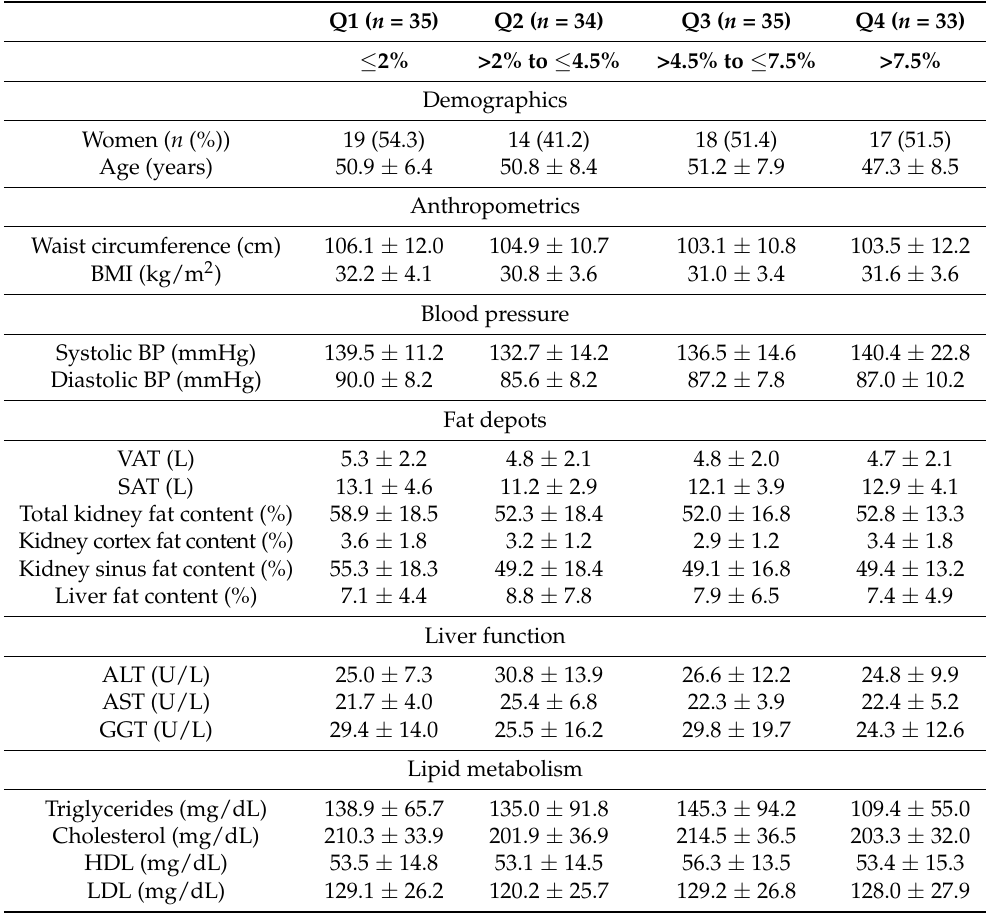
Table 1. Characteristics of the four weight loss groups (Q1 to Q4) at baseline, n =